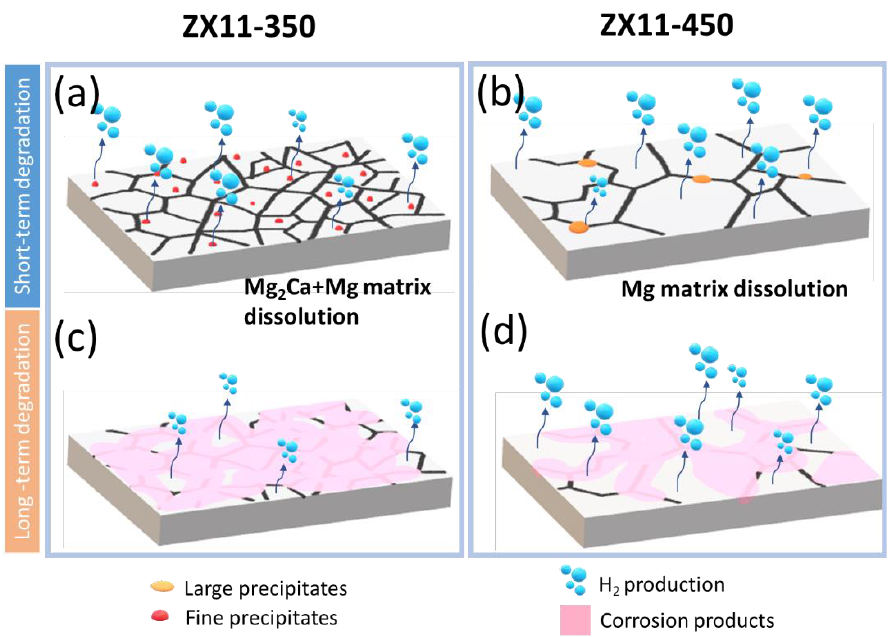
Figure 8. Illustration of the surface activity and passivation for short-term ( a , b ) and long-term ( c , d ) degradation process of ZX11-350 and ZX11-450 samples. degradation process of ZX11-350 and ZX11-450